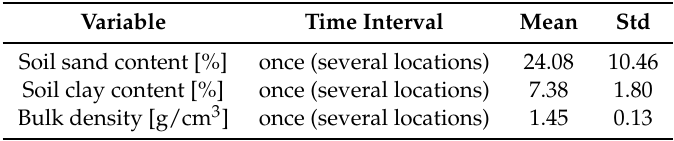
Table 2. Laboratory results for sand, clay, and bulk content of soil surface samples.